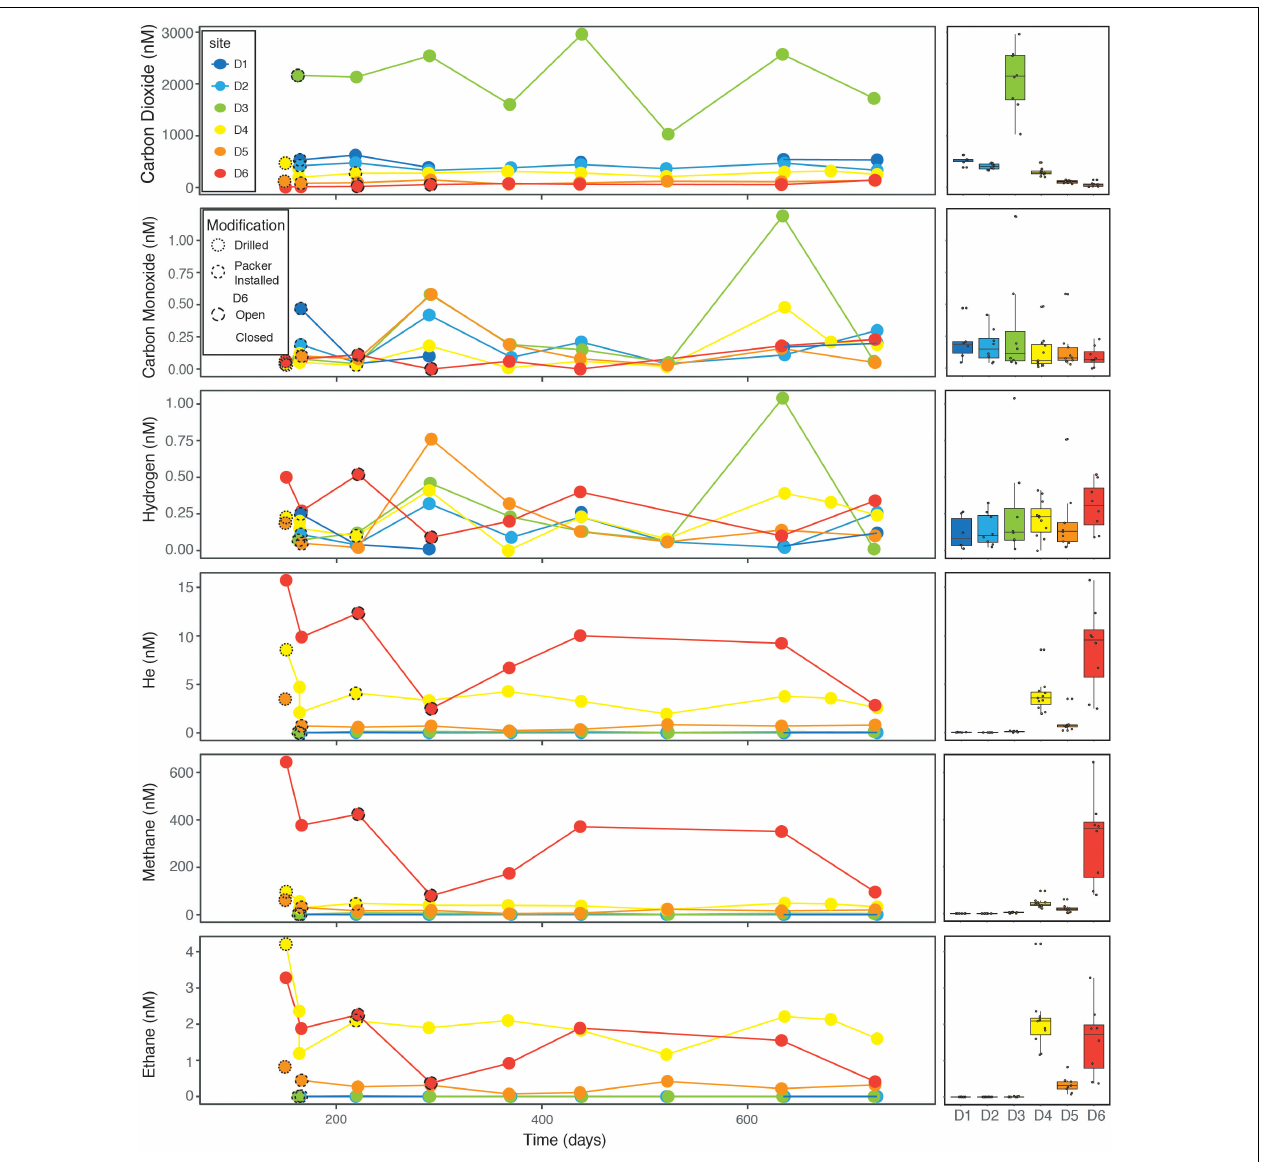
FIGURE 6 | Dissolved gas concentrations by site through time (left) and aggregate box plots illustrating average, interquartile range, and data points